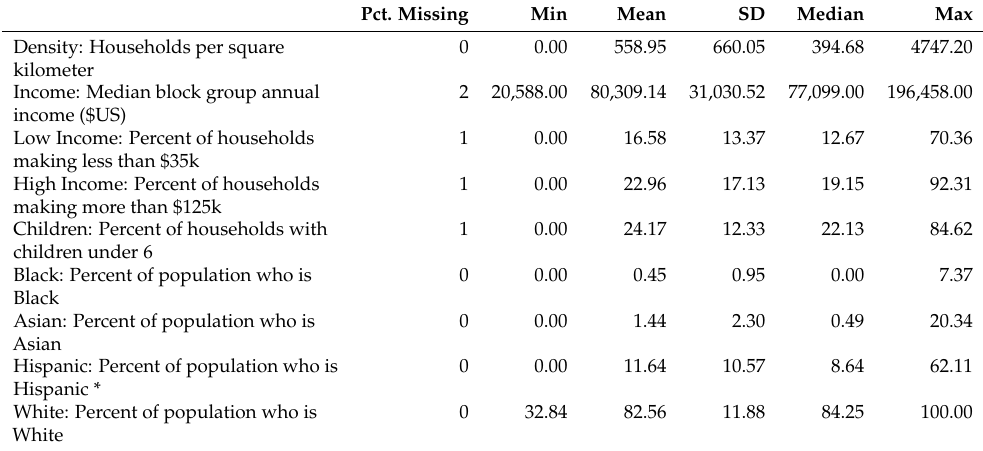
Table 1. Block Group Summary